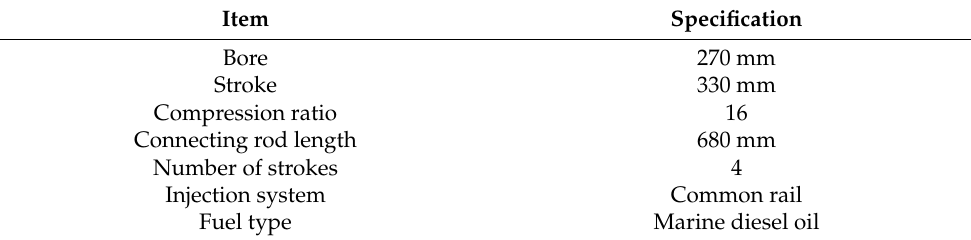
Figure 1. Marine diesel engine model. Table 1. Specifications of the engine.